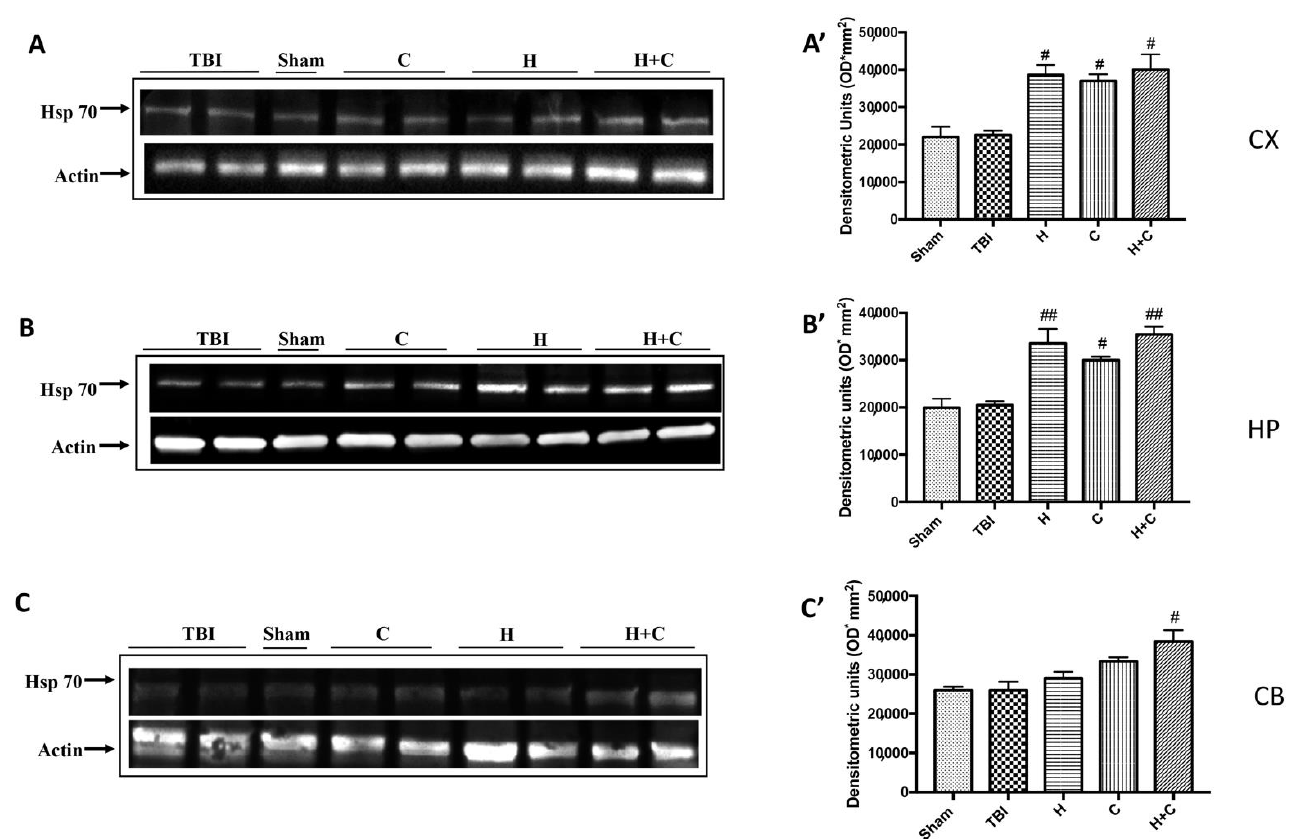
Figure 9. Effect of H. erinaceus or C. versicolor , or H. erinaceus + C. versicolor treatment on Hsp-70 protein after chronic TBI. Western blot analysis showed that the expression of Hsp-70 increased insignificantly in the TBI group in CX ( A ), HP ( B ) and CB ( C ) regions. H, C, and H + C treatment further significantly increased the expression of Hsp-70 in CX and HP regions ( A , B ). In CB area only H + C treatment significantly increased Hsp-70 expression ( C ). The data are expressed as the mean SEM from n = 5 mice/group. Densitometry analysis: ( A’ ) # p < 0.05 vs. TBI; # p < 0.05 vs. TBI; # p < 0.05 vs. TBI; ( B’ ) ## p < 0.01 vs. TBI; # p < 0.05 vs. TBI; ## p < 0.01 vs. TBI; ( C’ ) # p < 0.05 vs. TBI.